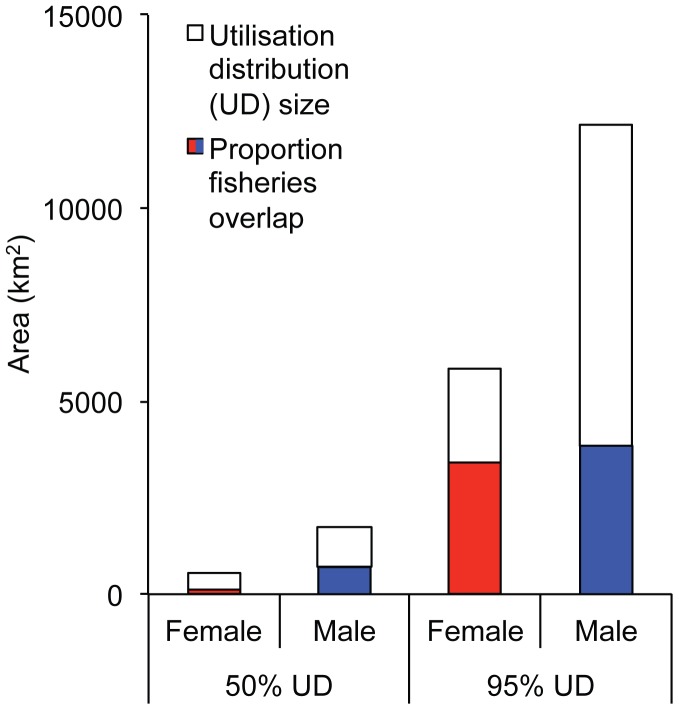
Utilisation distribution (UD) size of female and male juvenile New Zealand sea lions (Phocarctos hookeri).The proportion of UD overlap with squid trawl fisheries operations is indicated in red or blue.